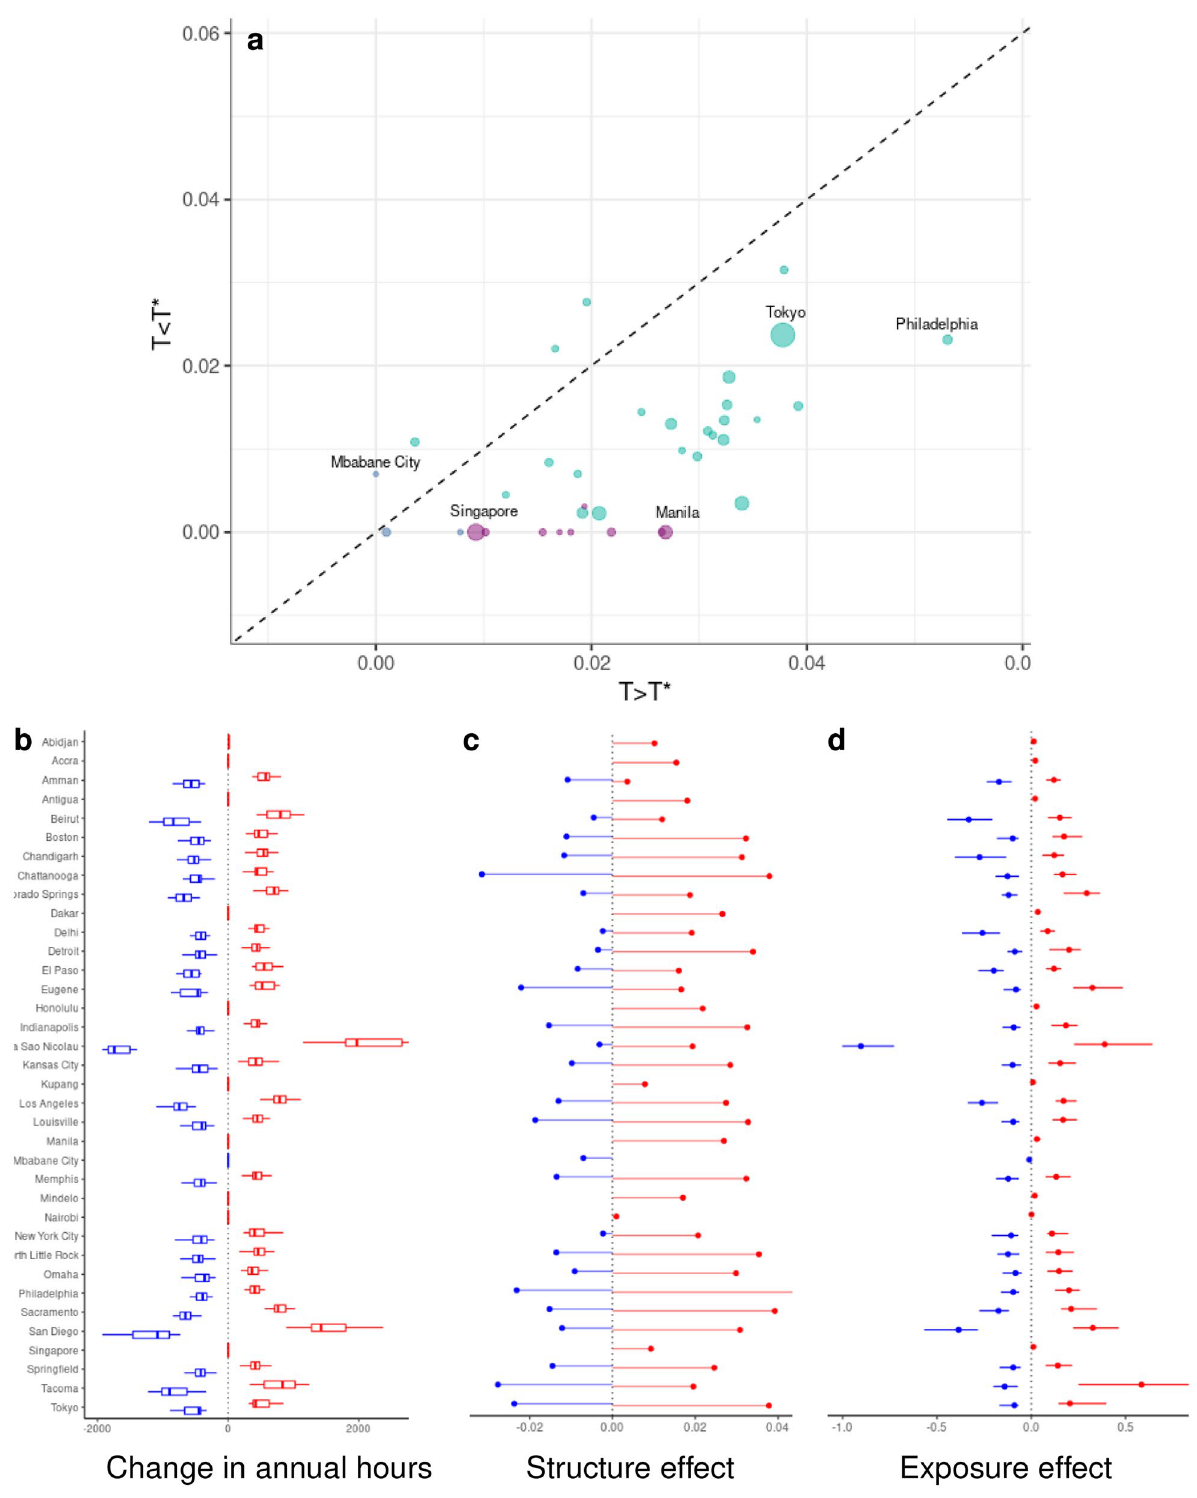
Figure 3. ( a ) Average fractional response of per capital urban electricity demand to temperatures above and below the set point temperature, T ∗ . Colors indicate type of demand response (turquoise—“V”-shaped, purple— increasing, cyan—unresponsive. ( b ) Change in hours over the year with temperatures above (red) and below (cyan) T ∗ . ( c , d ) Decomposition of the change in annual total electricity demand into the effects of demand response and shifts in the distribution of hourly